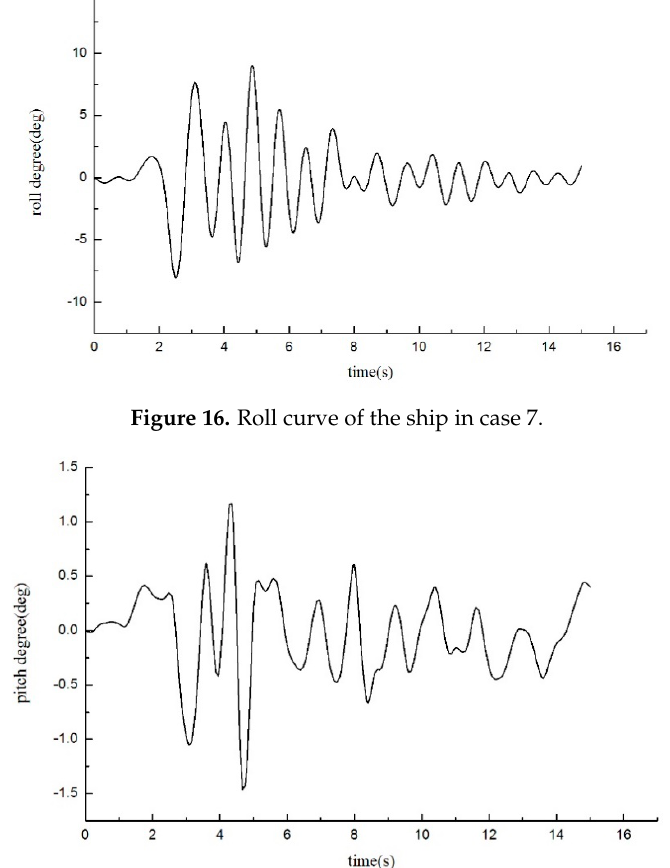
Figure 17. Pitch curve of the ship in case 7.